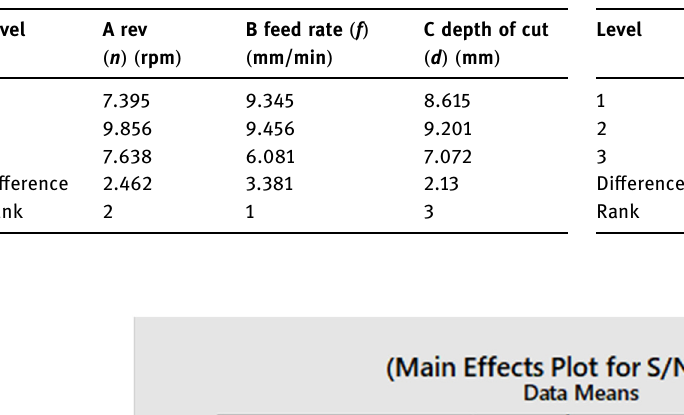
Table 5: S/N ratios of surface roughness values